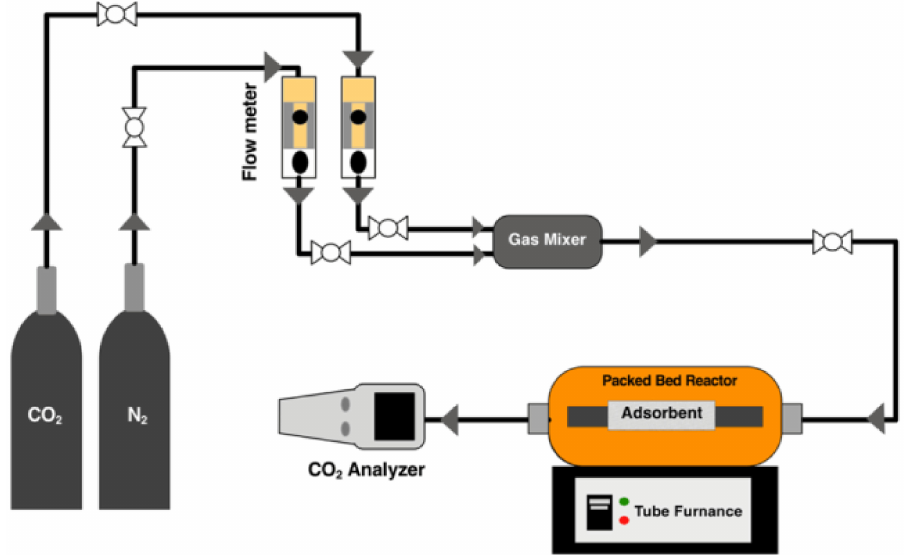
Figure 1. Process of CO 2 adsorption from CO 2 /N 2 gas mixture with fixed-bed